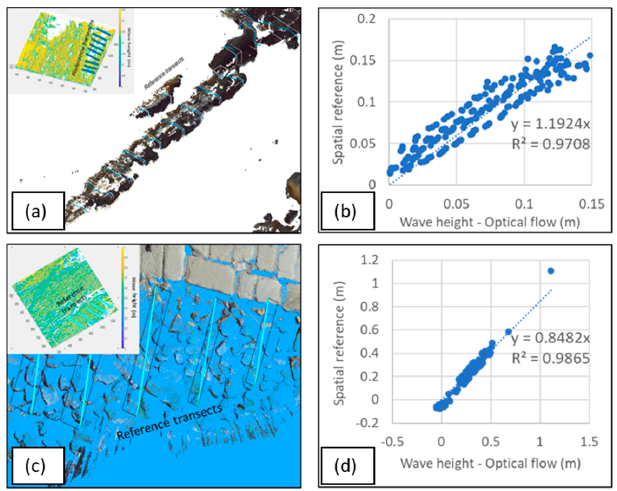
Figure 15. Validation of model results on Varco 11 with spatial reference; ( a ) reference transects extracted by TLS point clouds to obtain spatial reference in Sicily; ( b ) comparison of spatial reference of Sicily with wave height obtained by models; ( c ) reference transects extracted by TLS point clouds to obtain spatial reference in Portugal; ( d ) comparison of spatial reference of Portugal with wave height obtained by models.